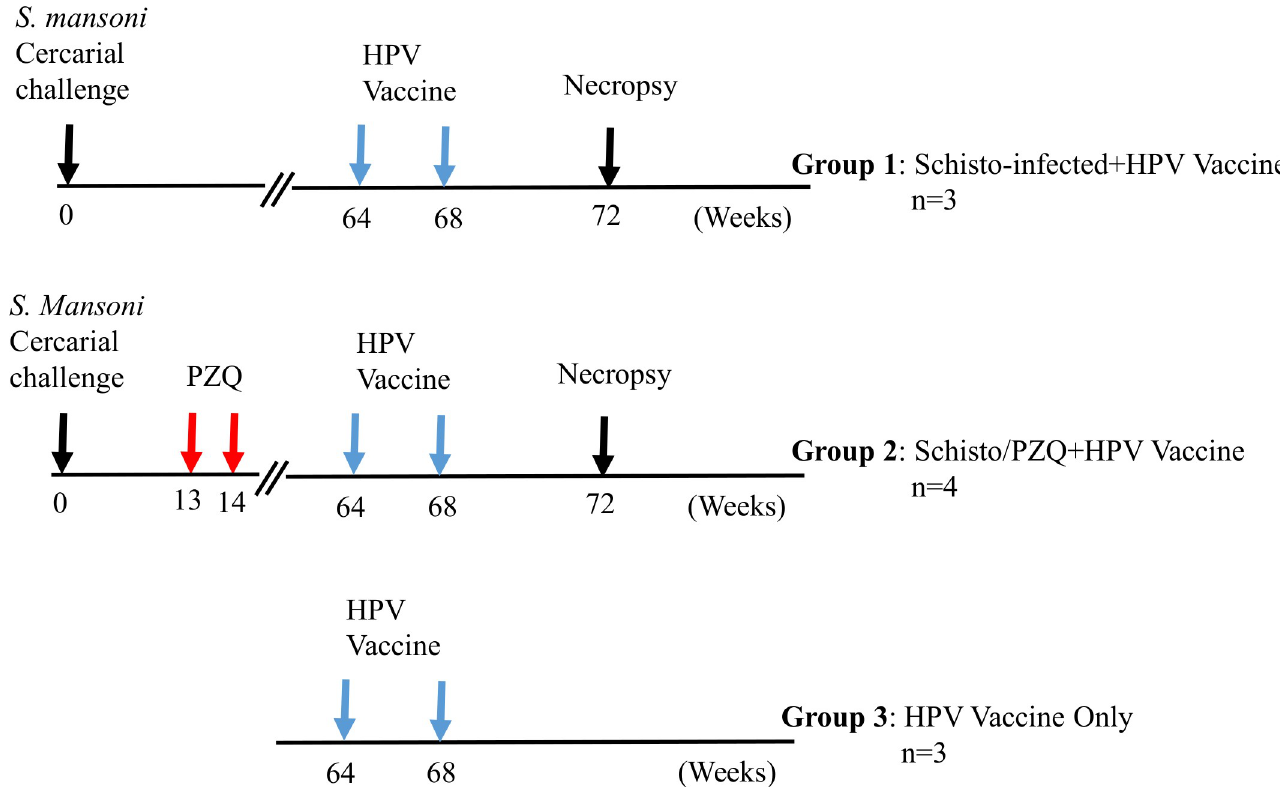
Fig 1. Experimental design. Three groups of animals were included in the experiment. i) animals infected with S. mansoni cercariae and later received Cervarix HPV vaccine (Schisto infected+HPV), ii) animal infected with S. mansoni, treated with praziquantel (PZQ) before receiving the HPV vaccine (Schisto/PZQ+ HPV) and iii) animals that received the HPV vaccine